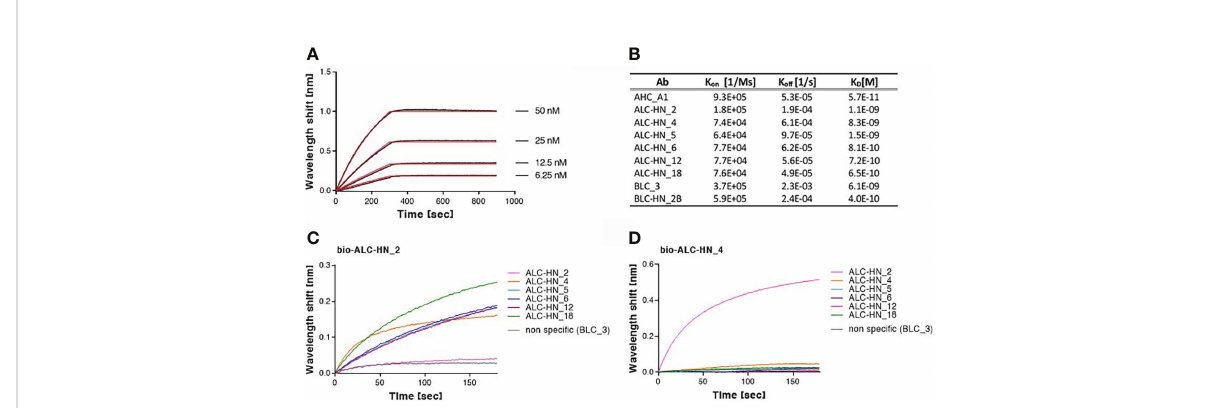
FIGURE 4 Biolayer interferometry (BLI) analyses of Centaur mAbs. (A, B) Binding kinetic of the selected mAbs. Each tested mAb was biotinylated, immobilized on a streptavidin sensor and incubated with increasing amounts of targeted antigen. Binding kinetics were fi tted using the 1:1 binding model. Each BLI analysis was independently-repeated at least two times, resulting in highly-similar calculated values. (A) Representative assay results are shown for ALC-HN_18 mAb. Gray sensograms represent binding pro fi les in the presence of each indicated antigen concentration. Fitting curves are depicted in red. Binding BLI curves of the nine tested mAbs are provided in Supplementary Figure S3. (B) Table of the binding kinetic parameters of the nine selected mAbs, presented as average values. (C, D) Identi fi cation of two distinct epitopes, recognized by the six selected anti-LC-H N /A mAbs by epitope binning. Each mAb was biotinylated (bio-mAb), immobilized on streptavidin sensor and saturated with LC-H N /A recombinant protein. The complex was then incubated with each one of the indicated mAbs. Background signals were obtained from parallel sensors incubated with the tested mAb itself (non-biotinylated) or non-speci fi c mAb. (C) Time 0 represent the binding to bio-ALC-HN_2-LC-H N /A complex, demonstrating a unique epitope targeted by this Ab. (D) Time 0 represent the binding to